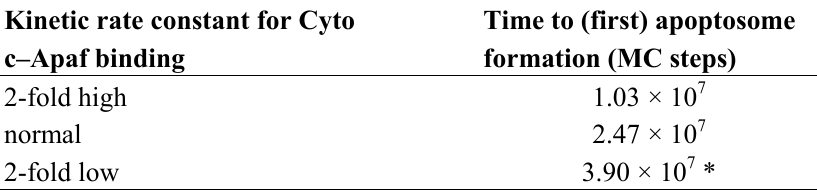
Table 2. Average time to first apoptosome formation as the rate constant for the cytochrome c-Apaf binding is varied. Data is averaged over 56 single cells (MC